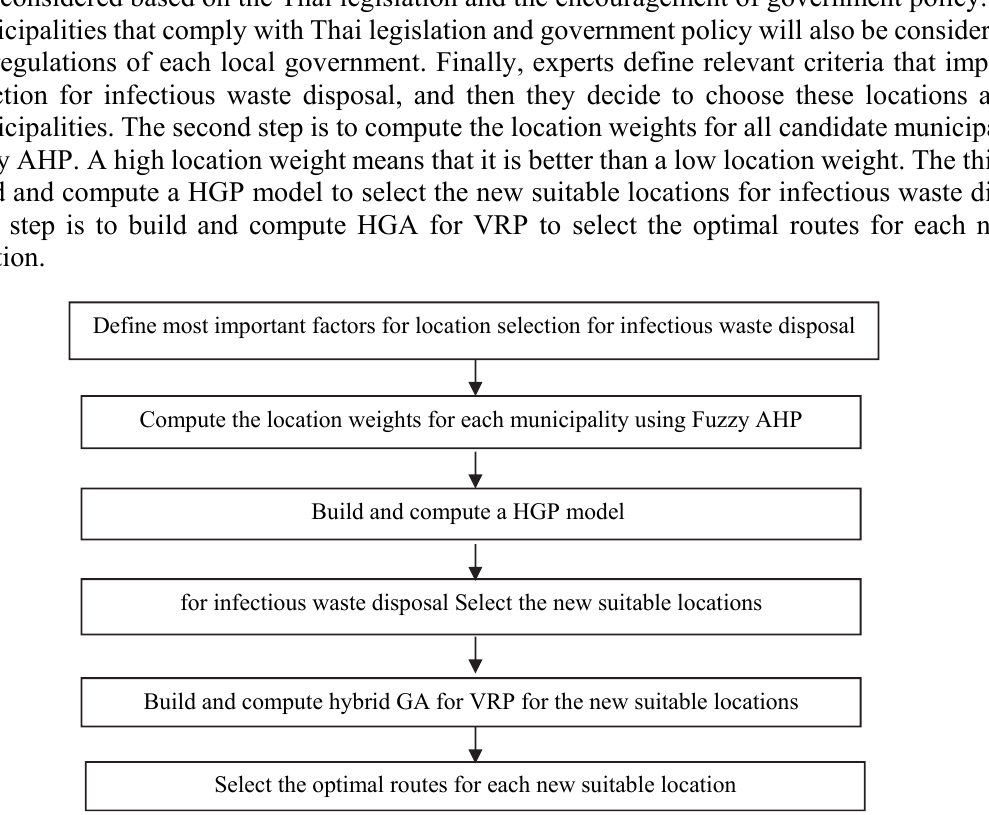
Fig. 1. The main steps of the study